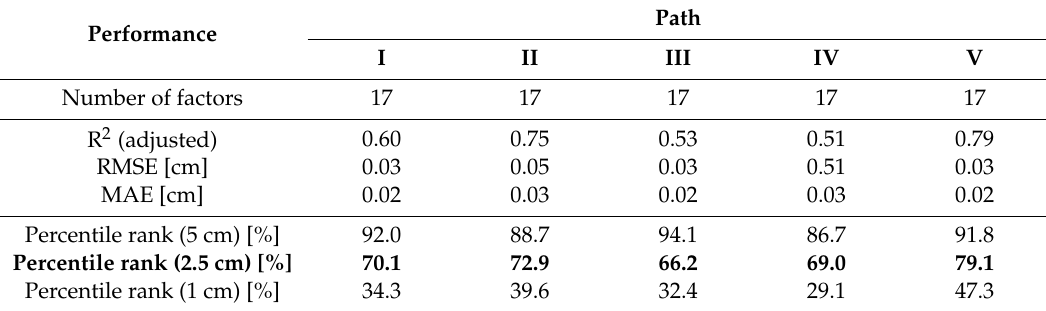
Table 8. Result of training and testing individual paths, based on model 8.